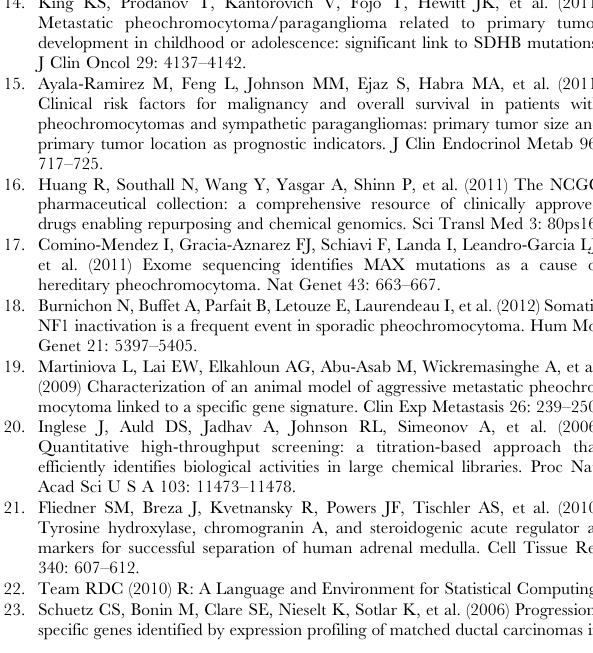
high-throughput screening with curve class 1.1, 1.2, 2.1 and 2.2, and maximal inhibition over 60%. Table S2 NPC library screening, complete list.Complete list of compounds from the NPC library including active, inconclusive and inactive compounds. The table includes the NCG compound identification number (Sample ID), chemical structure composi- tion, type of curve class based on the screening analysis, IC 50 (in m M), efficacy and the identification of the compound as active, inconclusive or inactive based on the curve classification illustrated in Figure S1. Table S3 Gene targets-drugs correlation. List of drugs and their targets compiled from databases as described in Materials and Methods (first column) or mapped to the microarray (second column). Table S4 Centrality scores. Top 20 genes based on the centrality score from the network common to SDHB (human) and MTT cells (murine), to look at the similarity of the dataset (MTT with SDHB) based on the microarray data. Table S5 Hubnodes scores. Top 20 hubnodes (nodes with the most association in the network) showing the node importance score (derived from the eccentricity method). The hubnode can be either a gene or a drug in the interrelating network. The highest is the number of associations of a hubnode, the highest is the